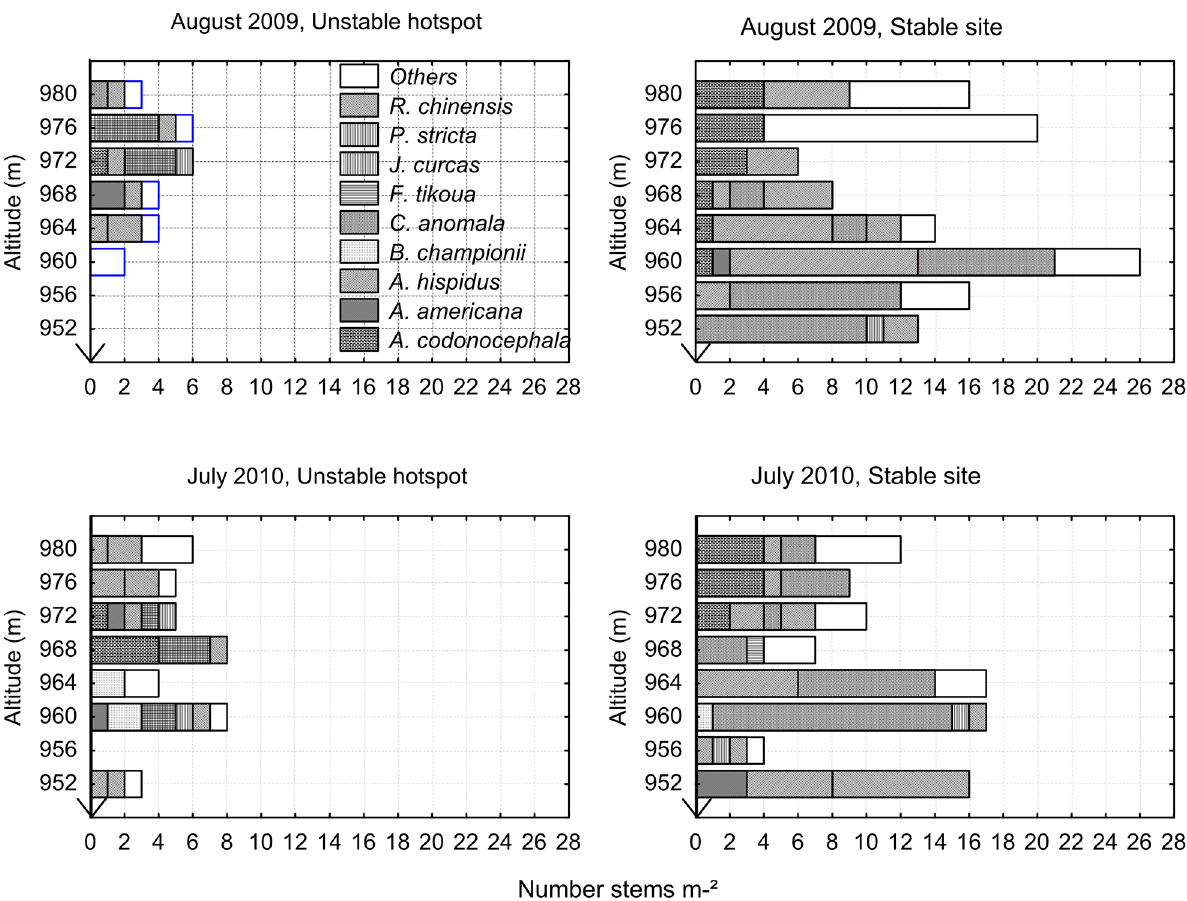
Figure 4. Plant abundance. Number of stems per square meter of each species present on the unstable hotspot and the stable site in 2009 and 2010. ‘‘Others’’ were composed of the following species: Bidens pilosa L., Celosia argentea L., Elsholtzia winitiana Craib, Indigofera sp., Malvastrum coromandelianum (L.) Garcke, Convolvulus arvensis L., Solanum verbascifolium L.